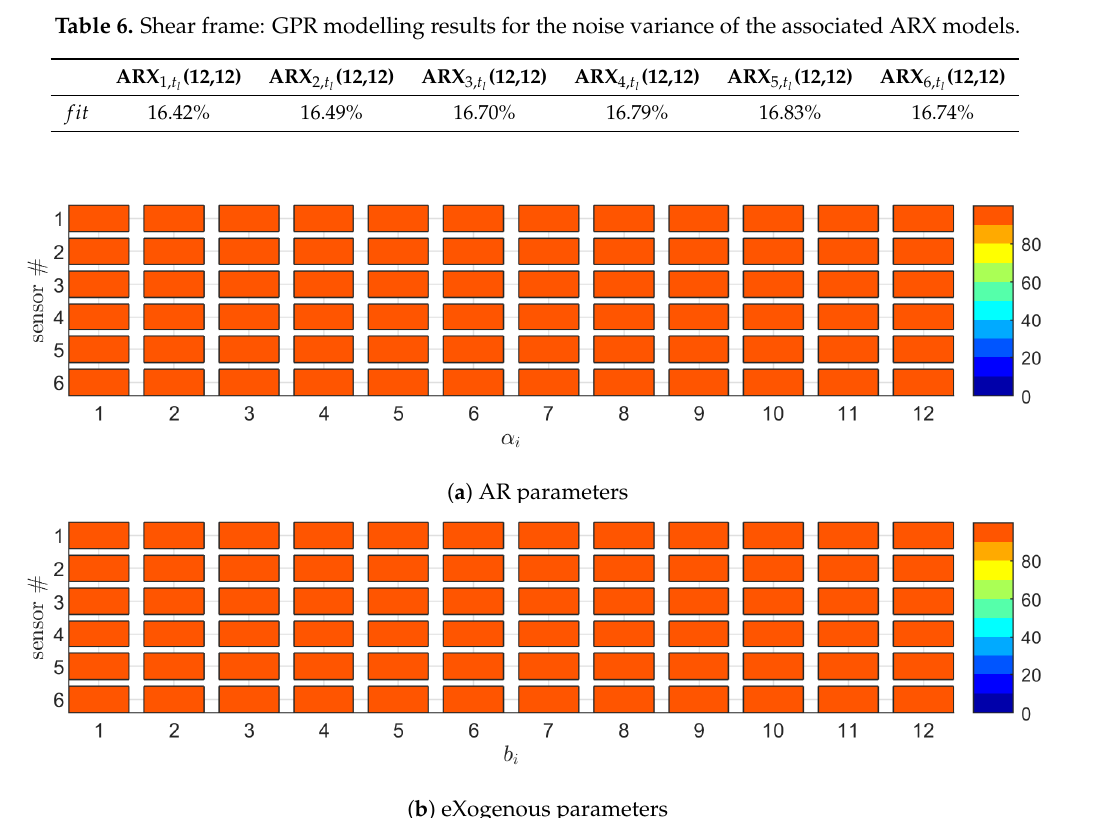
Figure 19. Shear frame: GPR modelling results for the AR and the eXogenous parameters of the associated ARX